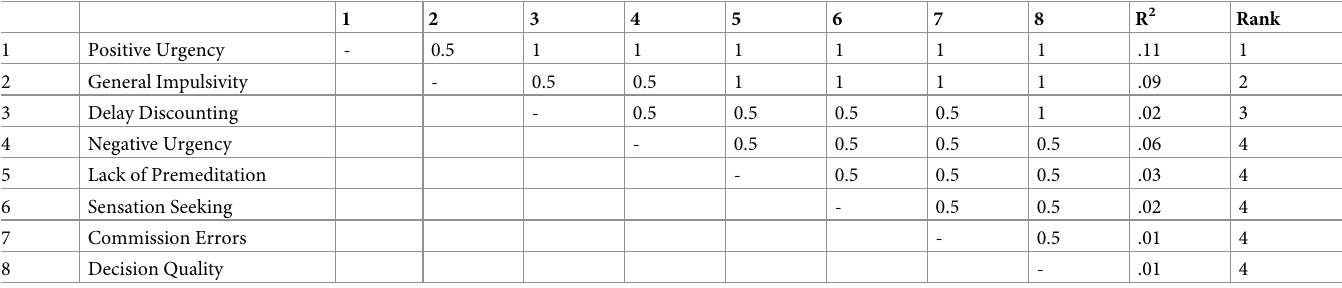
Table 8. Dominance matrix for Model 3 predicting the lifestyle facet arranged by order of complete